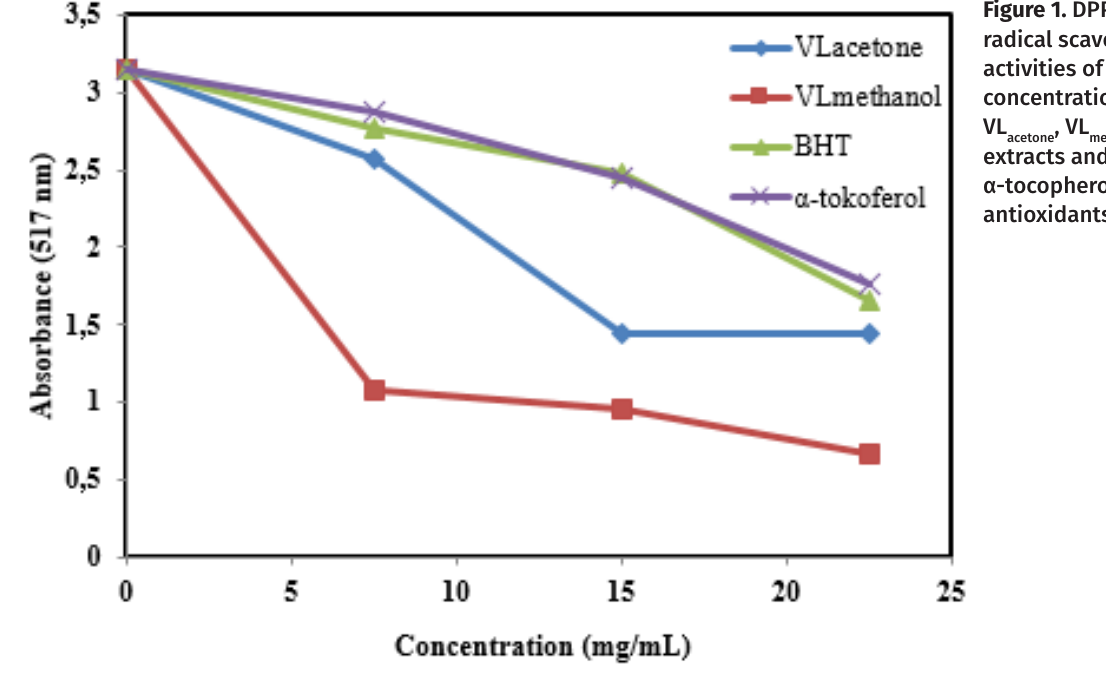
Figure 1. DPPH radical scavenging activities of different concentrations of VL , VL acetone methanol extracts and BHT, α-tocopherol